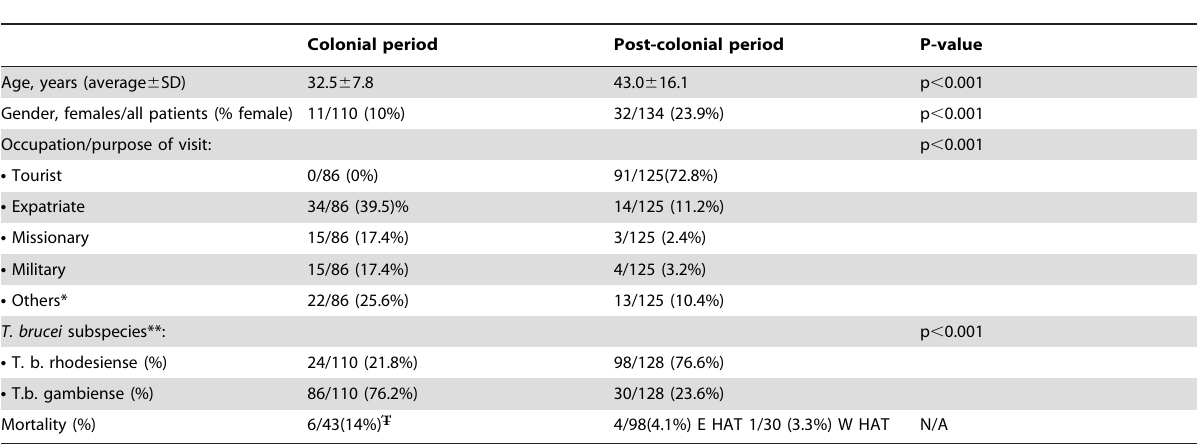
Table 1. Epidemiologic data and mortality rates of patients from non-endemic countries who acquired Human African Trypanosomiasis during the colonial period (1902–1966) and during the post-colonial period (1967–2012).